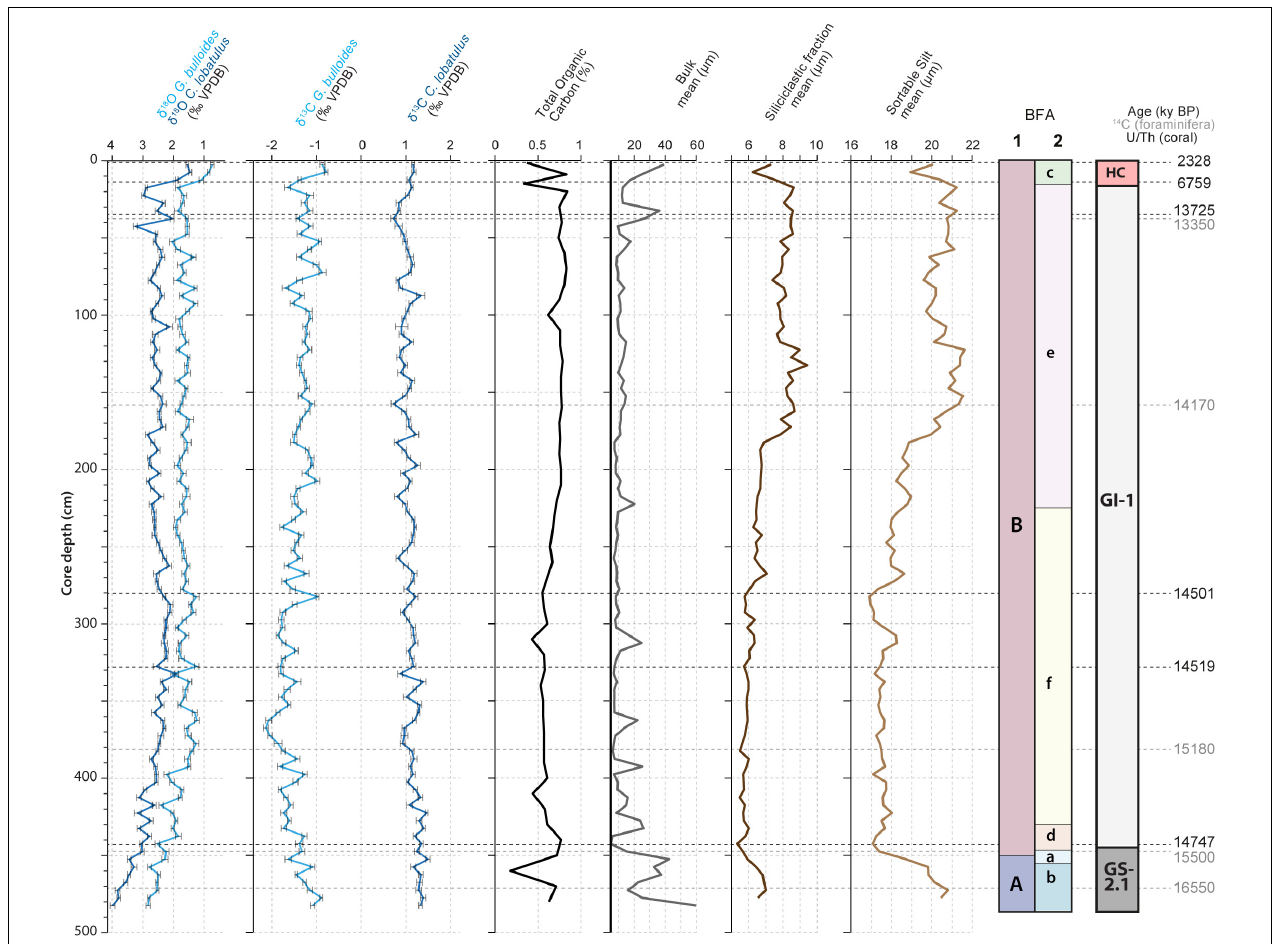
FIGURE 5 | Planktonic ( G. bulloides ) and benthic ( C. lobatulus ) δ 13 C values, Total Organic Carbon (%), mean grain size of bulk material ( µ m), siliciclastic ( µ m) and sortable silt fraction (corresponding to the 10 to 63 µ m siliciclastic grain size range, expressed in µ m). The benthic foraminiferal assemblages (BFA) identified at 47% similarity and at 62% similarity thanks to the hierarchical cluster analysis ( Figure 4 ) are illustrated. The stratigraphic column defined in Figure 2 , the G. bulloides planktonic and C. lobatulus benthic δ 18 O values and the U/Th coral and calibrated 14 C benthic foraminifera ages are provided as supporting